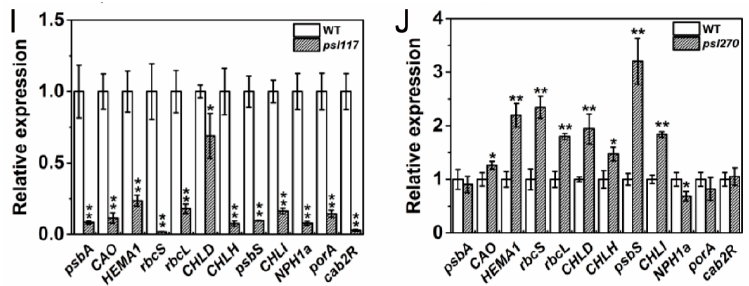
Figure 7. Expression profile of senescence, chlorophyll and photosynthesis-related genes at heading stage. ( A – E ) Expression of Osh36 , OsI57 , SGR and RCCR1 in WT and the mutants; ( F – J ) expression of photosynthesis-related genes in WT and the mutants. Error bars indicate ± SD ( n = 3). * p ≤ 0.05, ** p ≤ 0.01; Student t test.